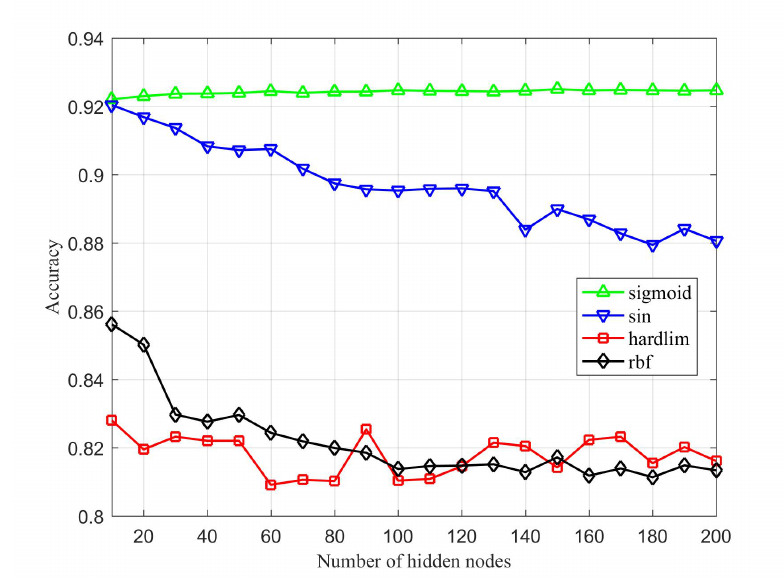
Figure 7. Accuracy of ILECA under different activation functions.